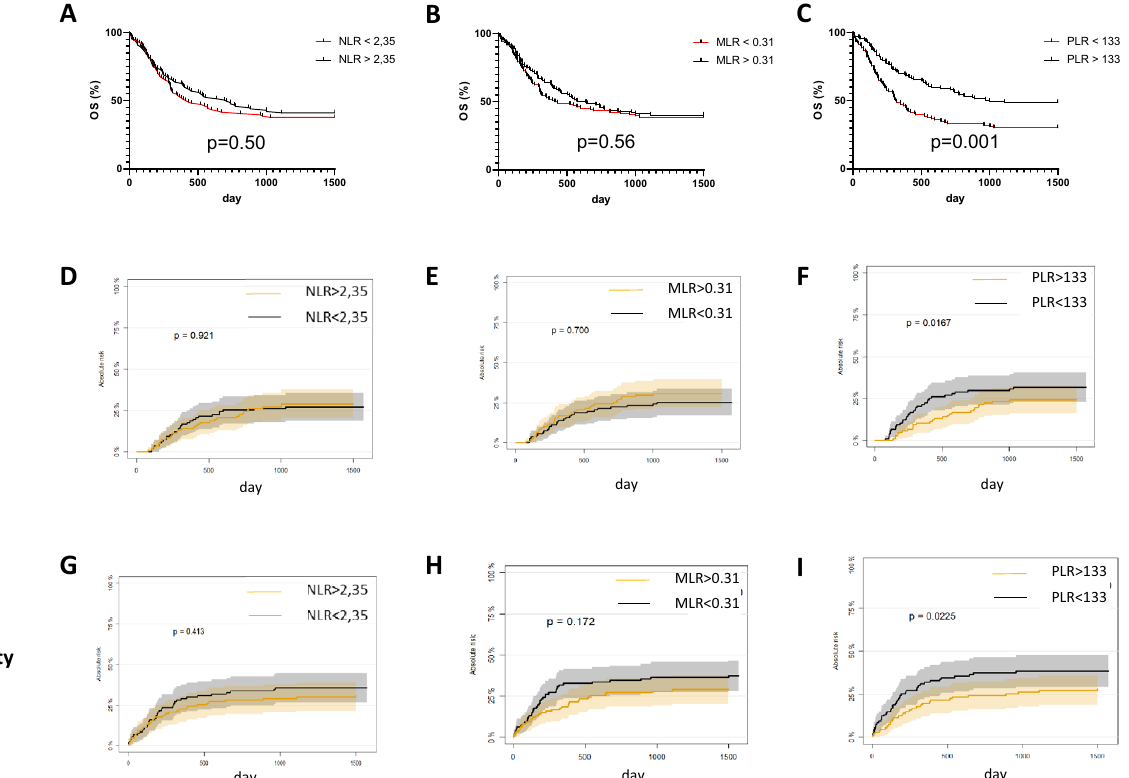
Figure 3. Association between NLR, MLR, PLR and Overall Survival (OS), Relapse as well as Non Relapse Mortality (NRM). ( A ), ( B ) and ( C ) show the association between OS (observation time 1500 days (= 4.1 years) post allogeneic HSCT) for NLR, MLR and PLR, while patients with PLR > 133 showed significant higher OS in comparison to patients with PLR < 133 ( p = 0.001). ( D ), ( E ) and ( F ) show the association between the 3 markers and relapse, while patients with PLR > 133 showed significant lower relapse in comparison to patients with PLR < 133 ( p = 0.016). ( G ), ( H ) and ( I ) show the association between NLR, MLR and PLR and NRM, while again patients with PLR > 133 showed significant lower NRM in comparison to patients with PLR < 133 ( p = 0.02).